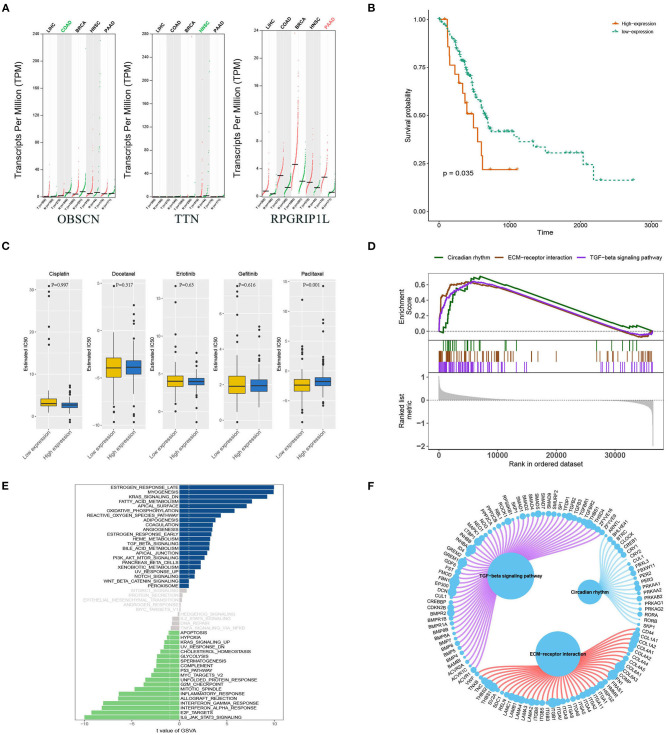
Bioinformatic analyses of RPGRIP1L gene expression and function. (A) Analysis of OBSCN, TTN, and RPGRIP1L mRNA expressions in five cancer types from TCGA database. The red and green colors of cancer types mean significantly difference (red, upregulated in tumor; green, downregulated in tumor, all compared with normal tissues). (B) The RPGRIP1L expression is related with PAAD patients' survival. (C) The RPGRIP1L expression is related with patients' sensitivity to paclitaxel. (D) GESA results showed that the RPGRIP1L expression was corelated with three pathways including circadian rhythm, ECM-receptor interaction, and TGF-β signaling pathways. (E) GSVA showed that RPGRIP1L expression was associated with several biological processes. Blue part means low expression, green part means high expression, gray part means no difference of RPGRIP1L expression. (F) GESA results of predicted RPGRIP1L binding targets in circadian rhythm, ECM-receptor interaction, and TGF-β signaling pathways. TCGA, The Cancer Genome Atlas; PAAD, pancreatic adenocarcinoma; GESA, gene-set enrichment analysis; GSVA, gene set variation analysis.